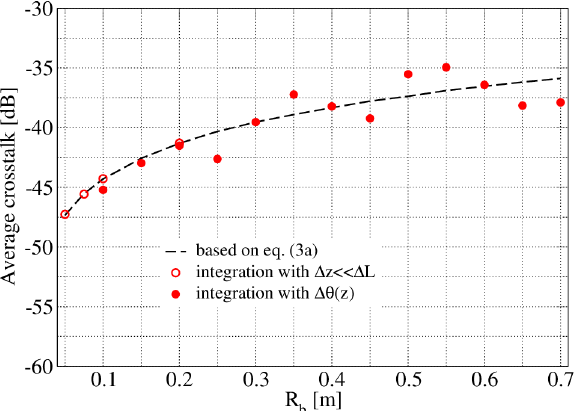
Figure 12. Average crosstalk for “ideal homogeneous” MCF parameters from Figure 1 of [13]. Dashed line: computed via numerical simulations based on Equation (3a) assuming averaging over the twist period. Open red circles: computed numerically by integrating Equation (1) over each segment length ∆ L with an integration step ∆ z much smaller than ∆ L and R b , and assuming averaging over the twist period. Filled red circles: computed numerically by integrating Equation (1) modified to include the accumulated phase ∆ θ (z) that includes the variation due to the twist with period of 0.134